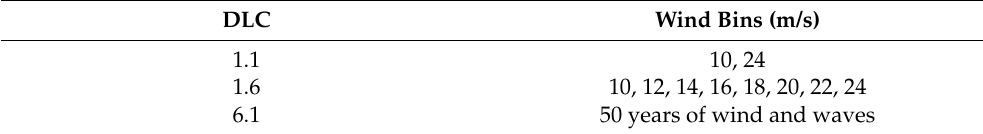
Table 10. Wind bins for DLC 1.1 and